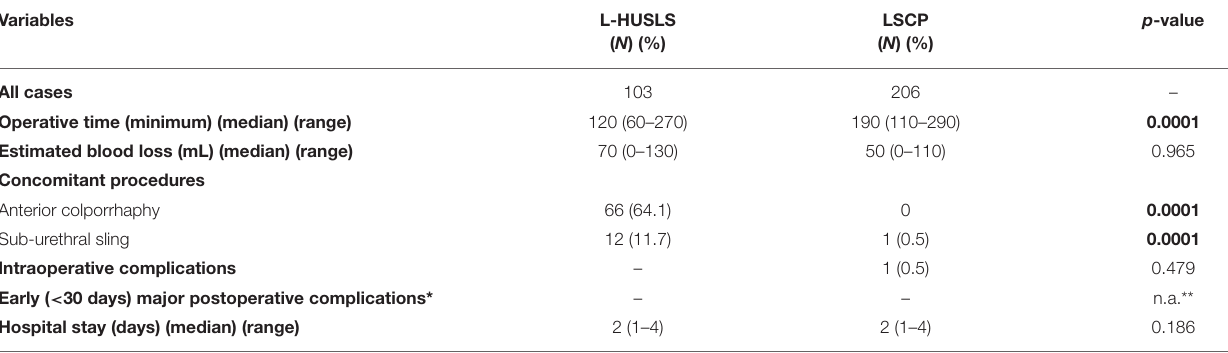
TABLE 2 | Perioperative data.